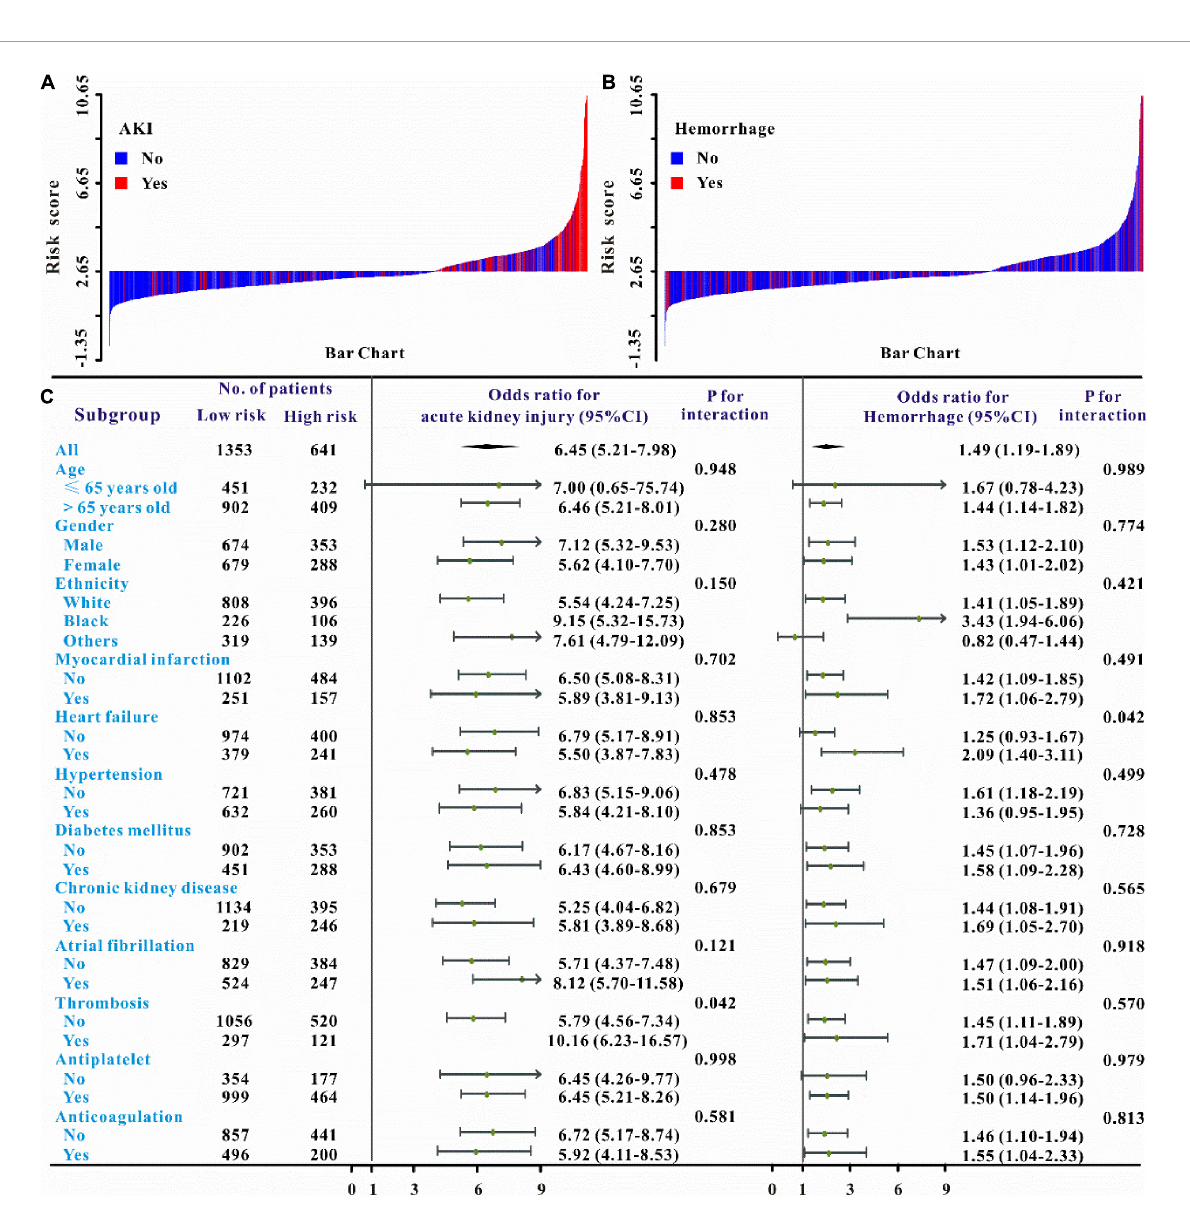
( Figure 2B ). The best cut-off value of the novel risk model is 2.65 according to the ROC analysis, and the low-risk ( ≤ 2.65) and high-risk ( > 2.65) groups were divided according to the